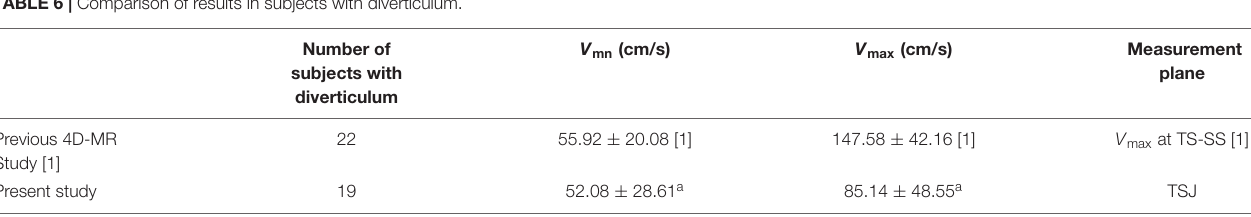
FIGURE 8 | Spectrotemporal results of in vivo Doppler and CFD. (A) Short-time Fourier transformation of the Doppler mainstream sinus flow (upper panel) and CFD mainstream sinus flow (lower panel, node 11131). (B) Short-time Fourier transformation of the Doppler diverticular flow (upper panel) and CFD diverticular flow (lower panel, node 13995). CFD, computational fluid dynamics. TABLE 6 | Comparison of results in subjects with